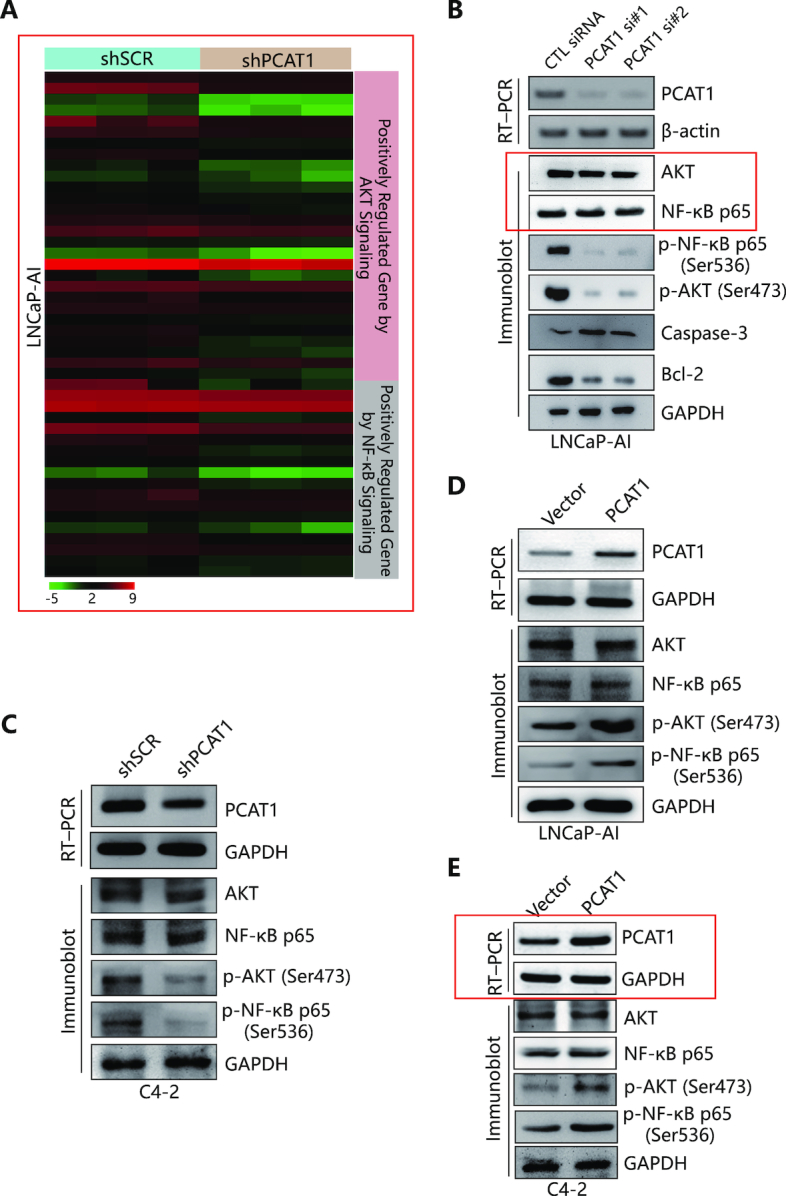
PCAT1 regulates AKT and NF-κB signaling pathways. (A) Heat map of key genes regulated positively by AKT or NF-κB signal pathways. These genes have decreased expression in PCAT1 depleted LNCaP-AI cells (P < 0.05). RNA-Seq data are displayed with log2 scaled FPKM (fragments per kilobase of transcript per million mapped reads) values for each gene in each sample. The gene names and other details for each specific gene were shown in Supplementary Table S4. (B) RT-PCR detection of PCAT1 and IB detection of indicated proteins in LNCaP-AI cells transfected with PCAT1 siRNAs. GAPDH was used as a loading control. (C) RT-PCR detection of PCAT1 and IB detection of AKT and NF-κB signaling molecules in C4-2 cells transfected with PCAT1 shRNAs. GAPDH was used as a loading control. (D) RT-PCR detection of PCAT1 in LNCaP-AI cell line with PCAT1 overexpression and IB detection of AKT and NF-κB signaling molecules. GAPDH was used as a loading control. (E) RT-PCR detection of PCAT1 in C4-2 cell line with PCAT1 overexpression and western blotting analysis of indicated proteins expression in PCAT1-overexpressed C4-2 cells. GAPDH was used as a loading control.